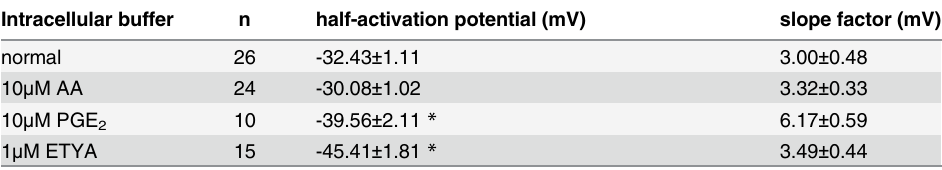
Table 1. The half-activation potential and slope factor of I-V curve of